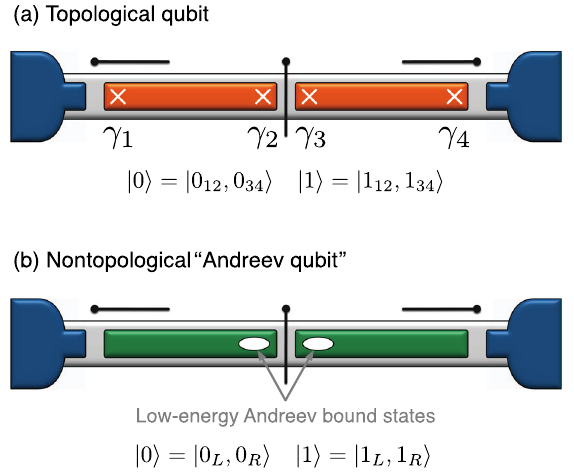
FIG. 9. (a) Topological qubit and (b) reference nontopological “ Andreev qubit ” that we seek to sharply distinguish. For the former, the qubit is stored in the topologically degenerate ground states encoded by Majorana zero modes; in the latter, the occupation numbers for “ accidental ” near-zero-energy Andreev levels specify the qubit states. Because of the very different sensitivity to local noise sources, we argue that the topological qubit ’ s coherence times and oscillation frequency exhibit non- trivial scaling relations that are generically absent in the Andreev qubit and can be used to identify topological protection in a modest pre-braiding